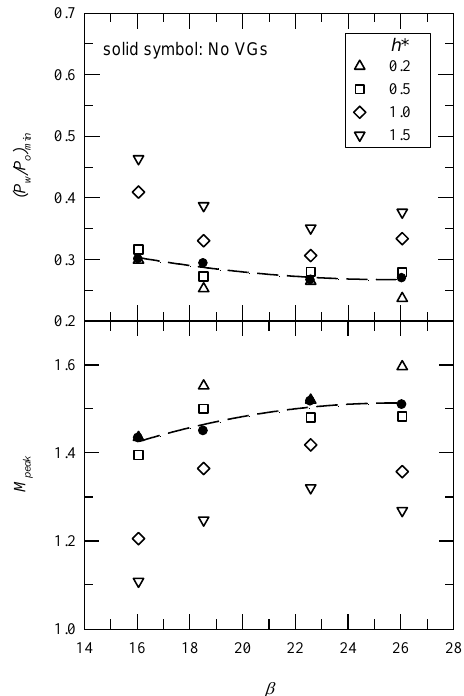
Figure 6. The effect of the presence of VGs on flow expansion near the corner’s apex .